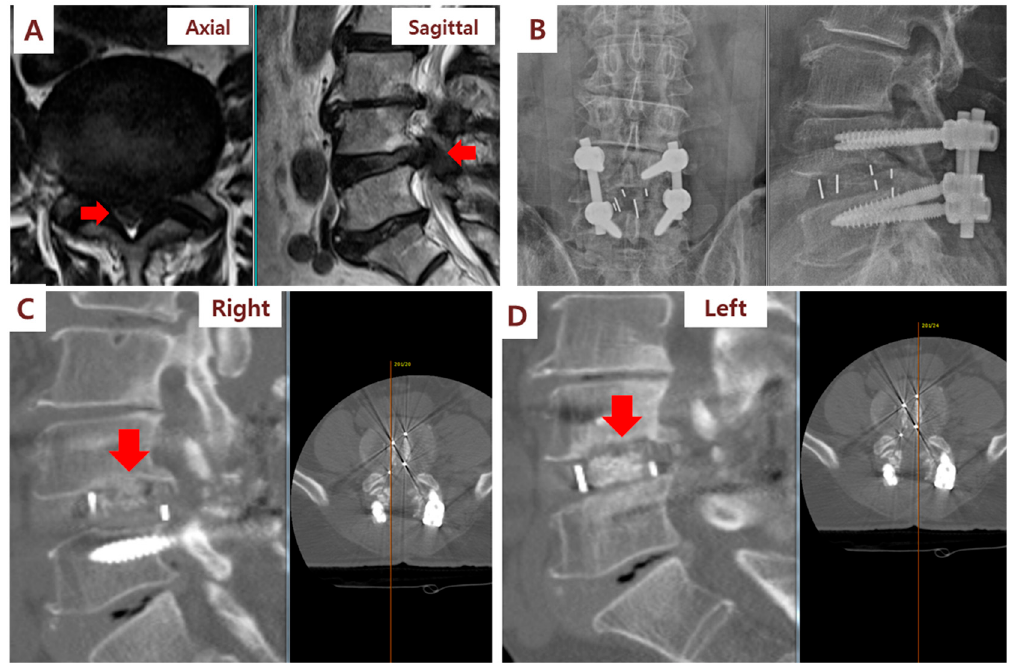
Figure 4. Illustration case (Patient No. 3): A 67-year-old male received posterior lumbar interbody fusion and pedicle screw fixation. ( A ) Preoperative lumbar axial and sagittal MRI demonstrating L4/L5 severe spinal stenosis. ( B ) Postoperative lumbar spine standing anteroposterior and lateral view. ( C ) CT sagittal view at 6 months after surgery showed fusion status (red arrow) of cages filled with SVF and β -TCP mixture on the right side of the patient. ( D ) By contrast, CT sagittal view showed no fusion status (red arrow) of cages filled with β -TCP alone on the left side.